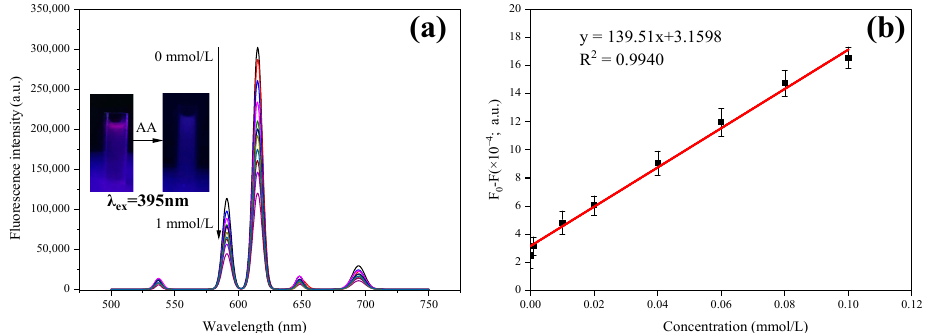
Figure 7. ( a ) Fluorescence emission spectra of CMC/Eu (III) in the presence of acrylamide with different concentrations in aqueous solution (0 mM–1 mM). Inset left: photos under UV light at 254 nm. ( b ) The linear relationship between the fluorescence intensity of CMC/Eu (III) at 615 nm and acrylamide concentration (0.1 μ M–100 μ m).